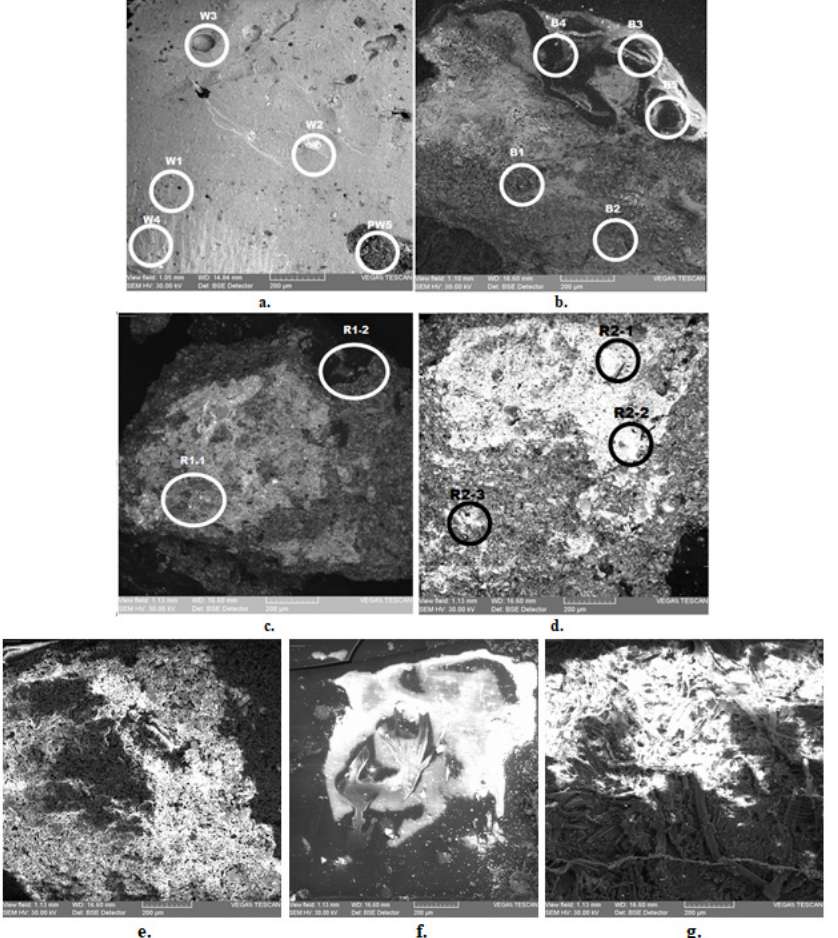
Figure 16. SEM microphotographs of some painting materials and support, analyzed in BSE: ( a ) samples of white color, zonal analyzed surfaces (W1–W5); ( b ) samples of blue color, entire analyzed surface (B0), and zonal analyzed surfaces (B1–B5); ( c ) samples of red 1 color, zonal analyzed surfaces (R1.1 and R1.2); ( d ) samples of red 2 color, zonal analyzed surfaces (R2.1, R2.2, and R2.3); ( e ) sample of yellow color (entire analyzed surface); ( f ) sample of varnish (entire analyzed surface); ( g ) sample of support (entire analyzed surface). Table 1. Elemental composition of colors, varnish, and substrate.